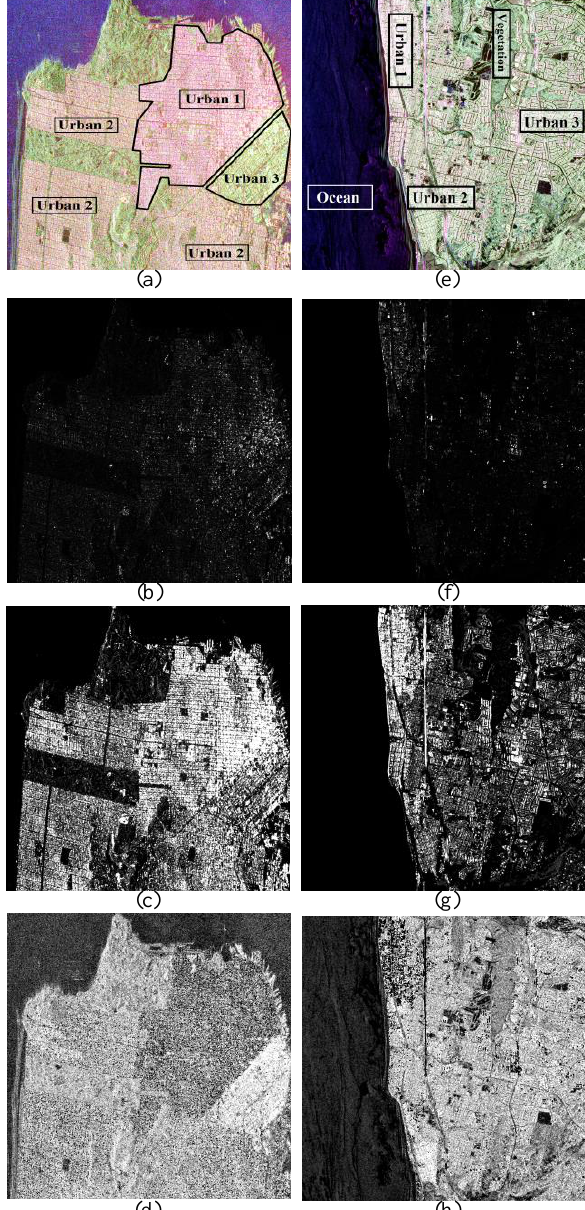
Figure. 1. San Francisco Bay study area: Pauli RGB image (a), left and right helix difference target map (b), detected built-up area (c), and helix scattering component of Yamaguchi target decomposition (d). Southern California Coast study area: Pauli RGB image (e), left and right helix difference target map (f), detected built-up area (g), and helix scattering component of Yamaguchi target decomposition